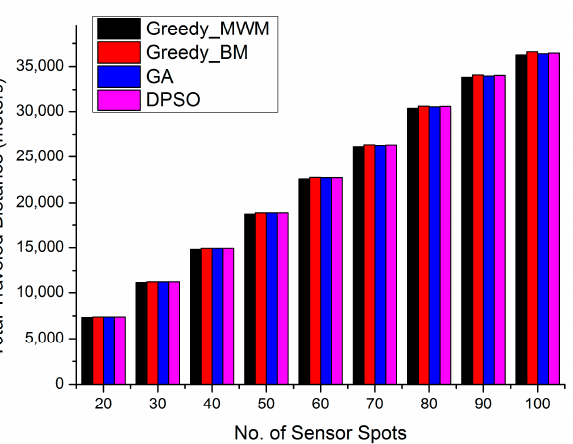
Figure 5. Total traveled distance under the greedy algorithms, genetic algorithm (GA), and discrete particle swarm optimization (DPSO) algorithm.